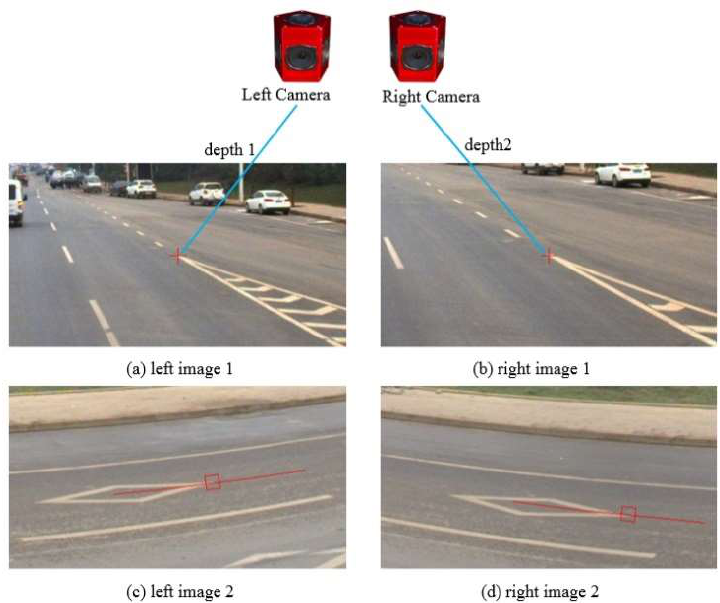
Figure 6. The preprocessing for scale and rotation. To reduce the scale changes between stereo image patches, we can resample ( a ) based on the ratio depth1/depth2 or resample ( b ) based on depth2/depth1. As for rotation, both of the patch windows could be aligned to the tangent direction of the current point, as shown on ( c , d